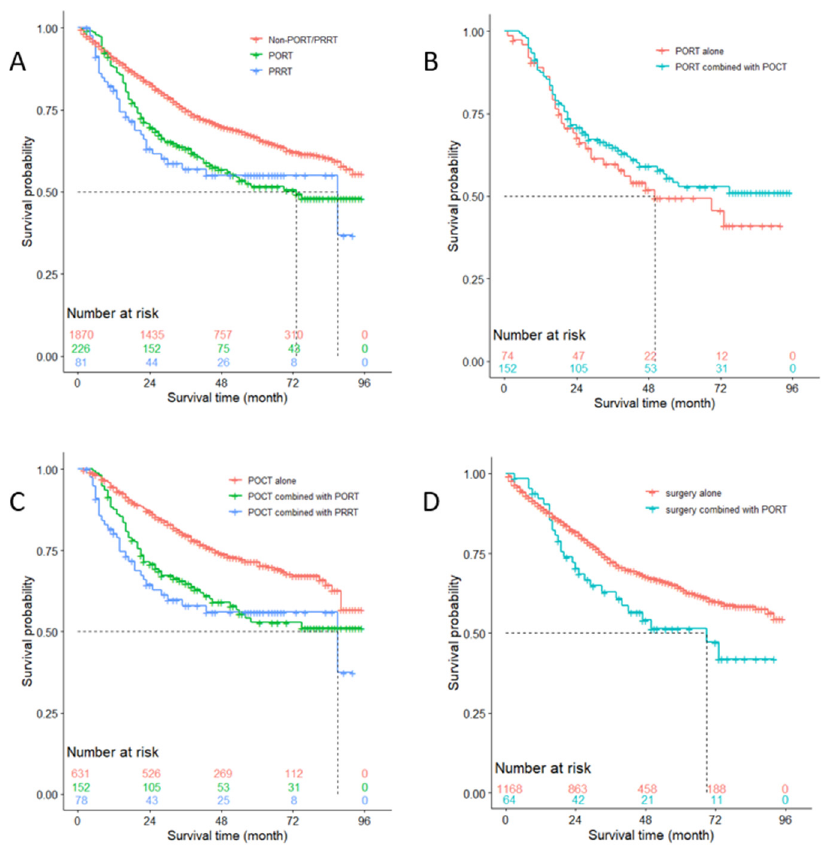
Figure 3. Overall survival of patients with N0 stage ( A ) who received Non-PORT/PRRT versus PORT ( p < 0.001), Non-PORT/ PRRT versus PRRT ( p = 0.002), and PORT versus PRRT ( p = 0.605); ( B ) who received PORT alone versus PORT combined with POCT ( p = 0.330); ( C ) who received POCT alone versus POCT combined with PORT ( p < 0.001), POCT alone versus POCT combined with PRRT ( p < 0.001), and POCT combined with PORT versus POCT combined with PRRT ( p = 0.522); and ( D ) who featured < 3 positive lymph nodes, surgery alone versus surgery combined with PORT ( p = 0.028). POCT = postoperative chemotherapy; PORT = postoperative radiotherapy; PRRT = preoperative radiotherapy; Non-PORT/PRRT = neither PORT nor